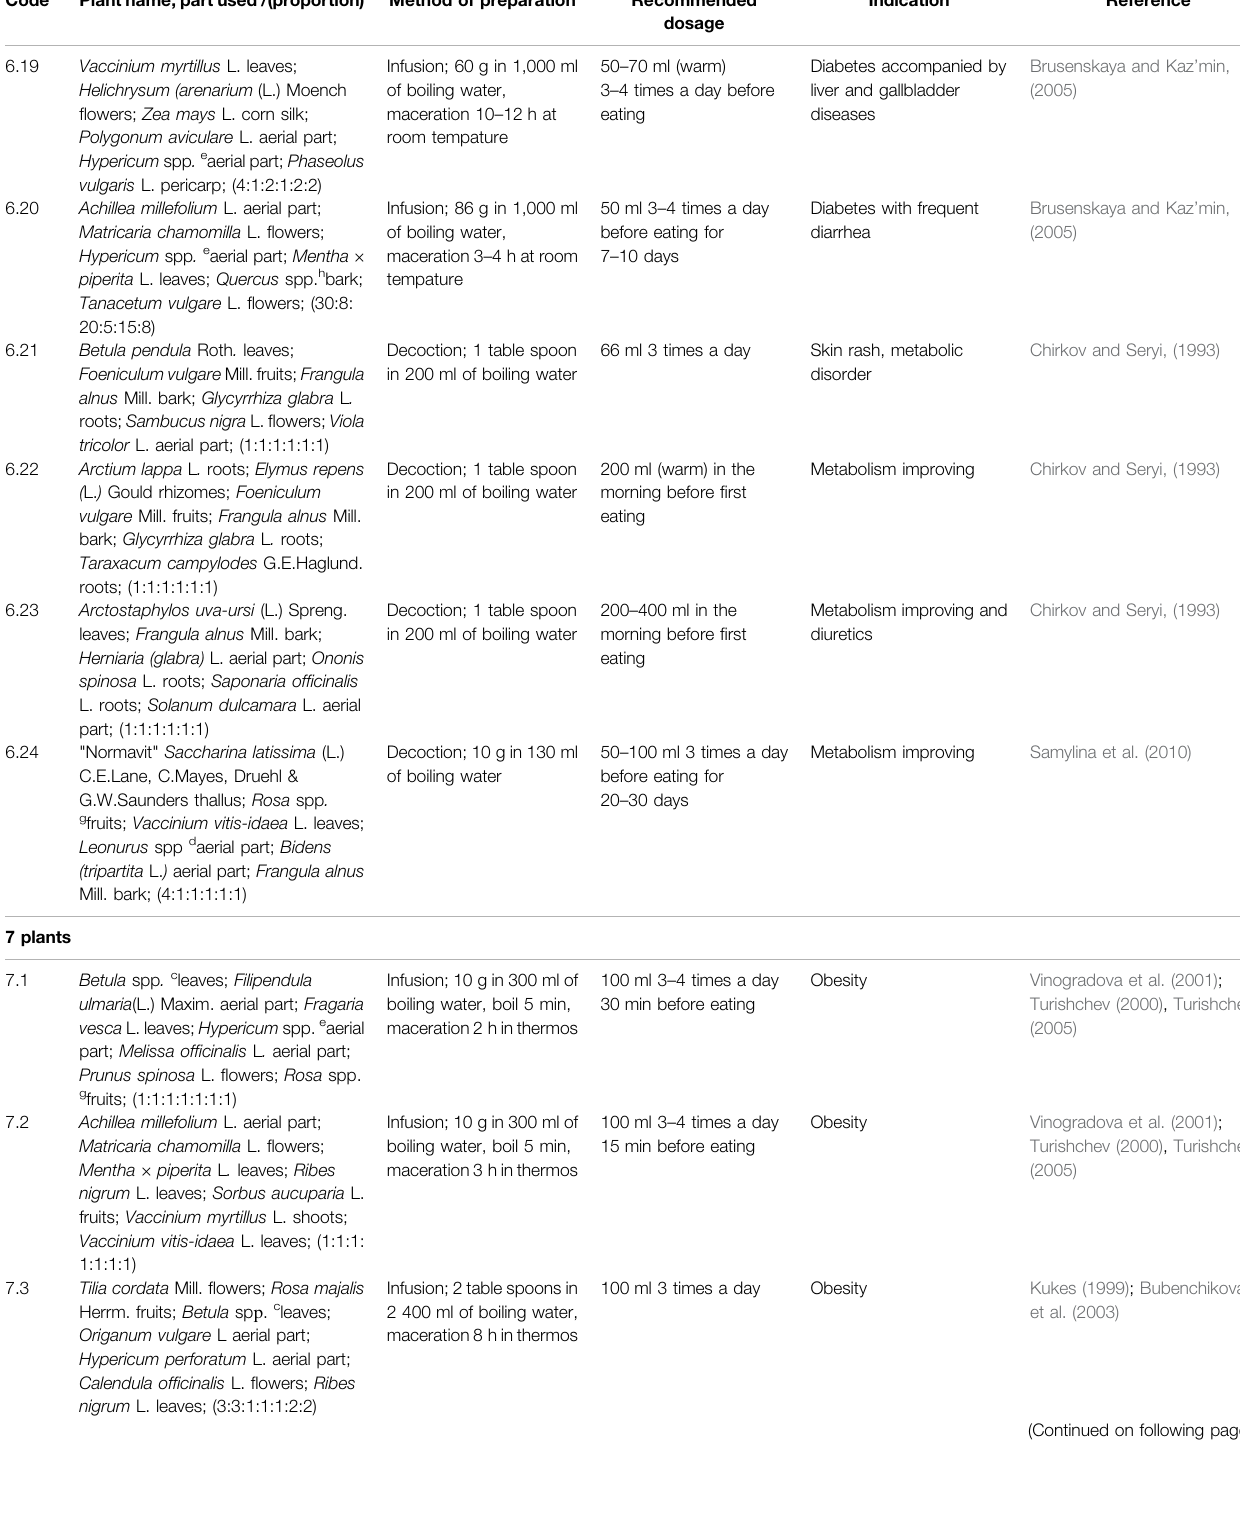
TABLE 1 | ( Continued ) The list of medical species used for the management of diabetes and related disorders in Russia. Code a Plant name, part used /(proportion) Method of